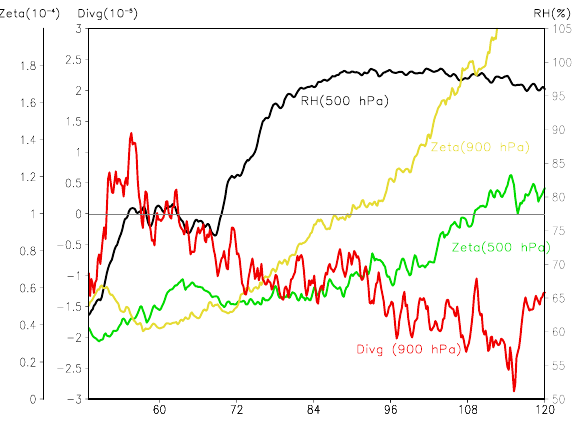
Fig. 15. Time evolution of 500hPa relative humidity (units: %), 900hPa divergence (units: 10 − 5 s − 1 ), 500hPa and 900hPa relative vorticity (units: 10 − 4 s − 1 ) averaged in a 2 ◦ × 2 ◦ box following the moving pouch center from Hour 50 to Hour 120.